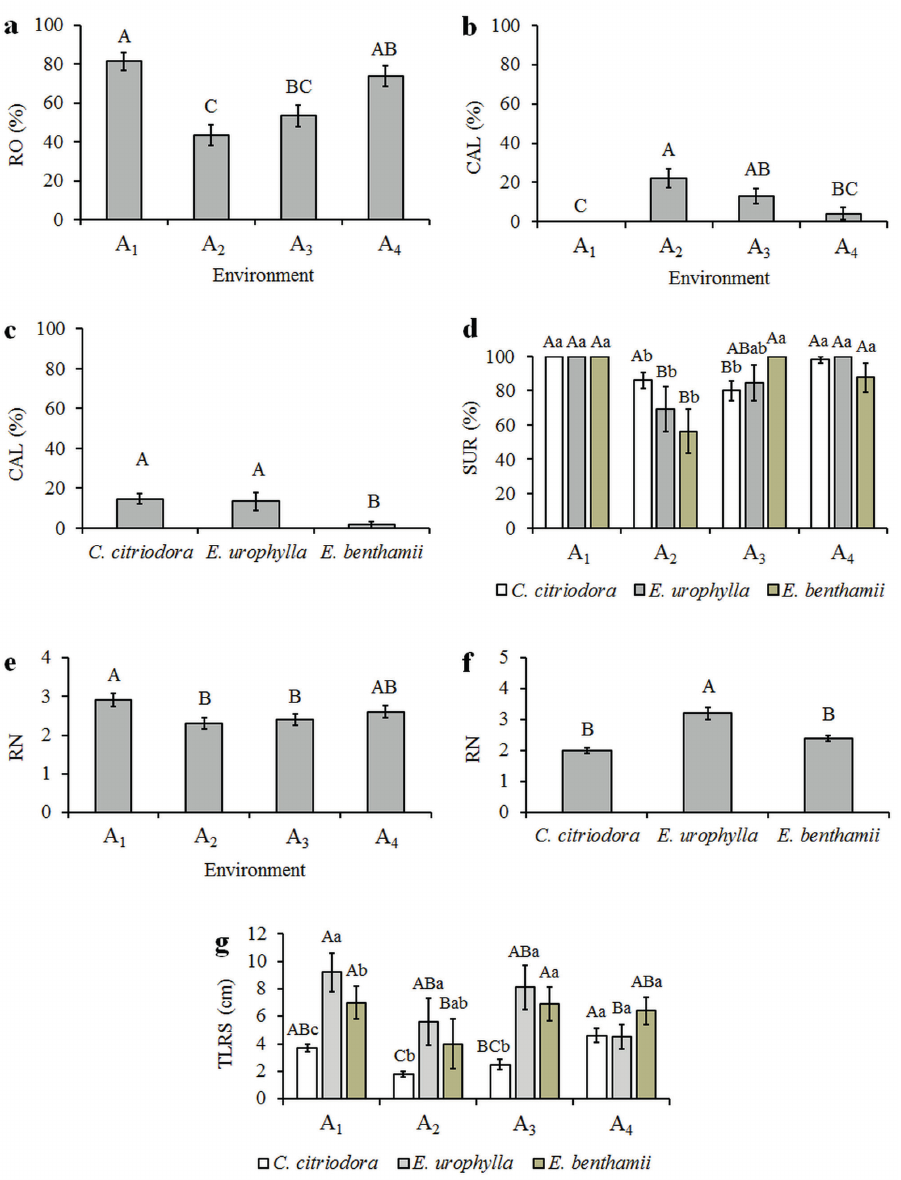
Figure 3 - Effects of distinct environments on microcuttings of Corymbia citriodora , Eucalyptus urophylla and E . benthamii after 22 days of rooting. a – Percentage of adventitious rooting (RO) in the environments. b – Percentage of callogenesis (CAL) in the environments. c – Percentage of callogenesis (CAL) for each species. d – Percentage of survival of the microcuttings (SUR) for each species. e – Number of adventitious roots emitted per microcutting (RN) in each environment. f – Number of adventitious roots (RN) per species. g – Total length of the roots for each microcutting (TLRS) in the environment for each species. A – shade house with no fogging; A – greenhouse with 1 2 ventilation but no fogging; A – greenhouse with both ventilation and fogging; A – greenhouse with 3 4 no ventilation but with fogging. a, b, c, e and f – Mean values followed by the same letter represent no significant difference according to Tukey’s test ( P < 0.05). d, g – Mean values followed by the same lowercase letter for the environment among the species, and mean values followed by the same capital letter among the environments for the same species represent no differences according to Tukey’s test ( P < 0.05). The values are presented as the mean ± standard